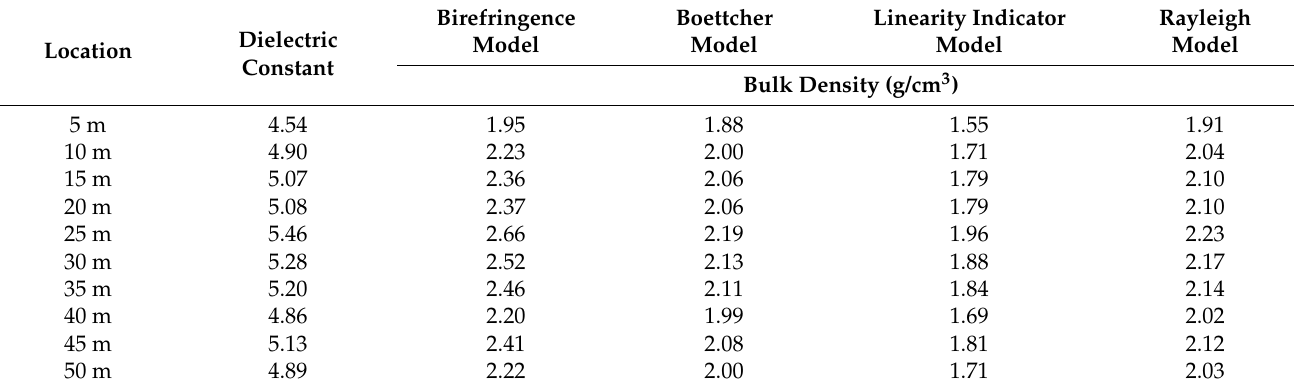
Table 6. Density of the asphalt concrete layer in Line 4 calculated by the four prediction models.